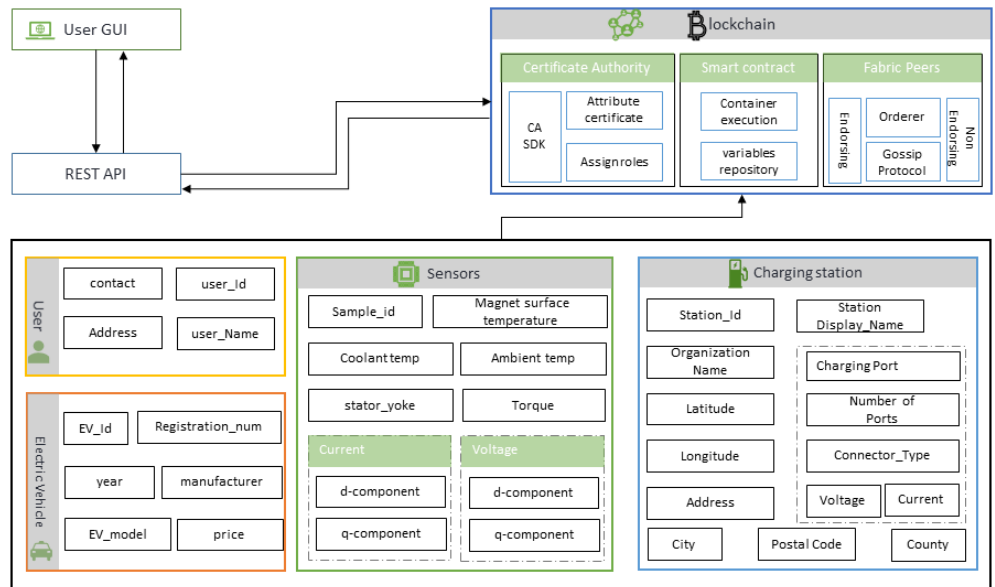
Figure 6. Blockchain based